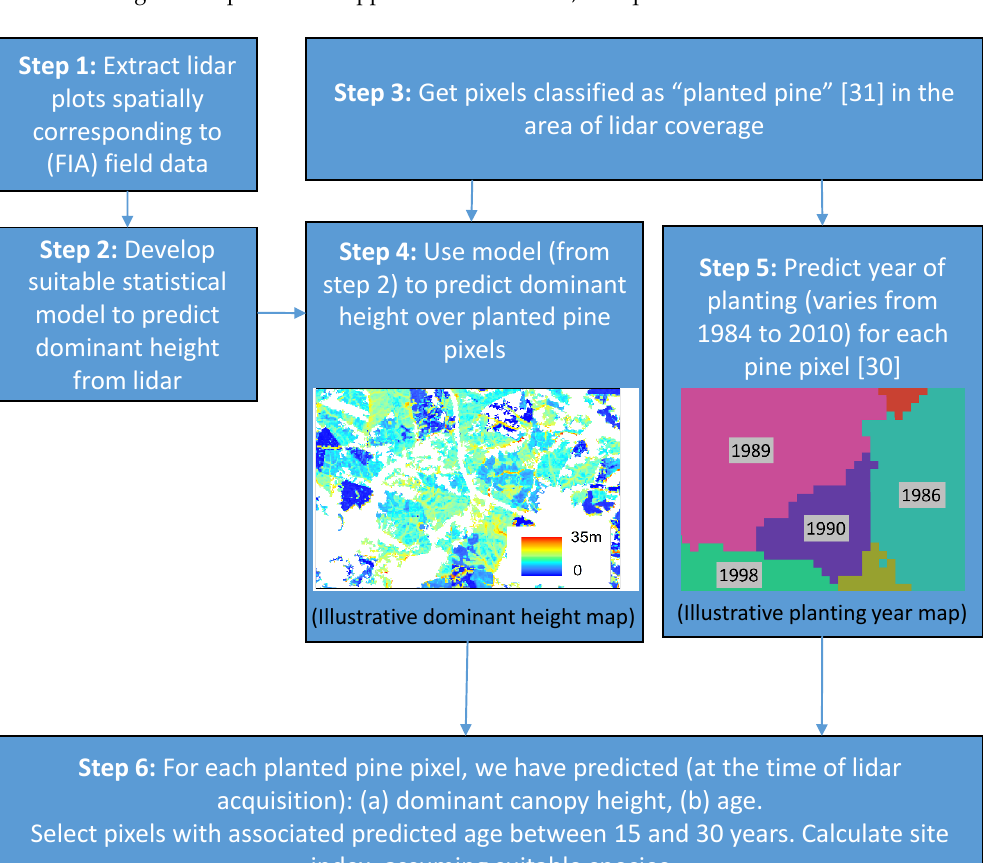
Figure 5. Major steps involved in the generation of the site index